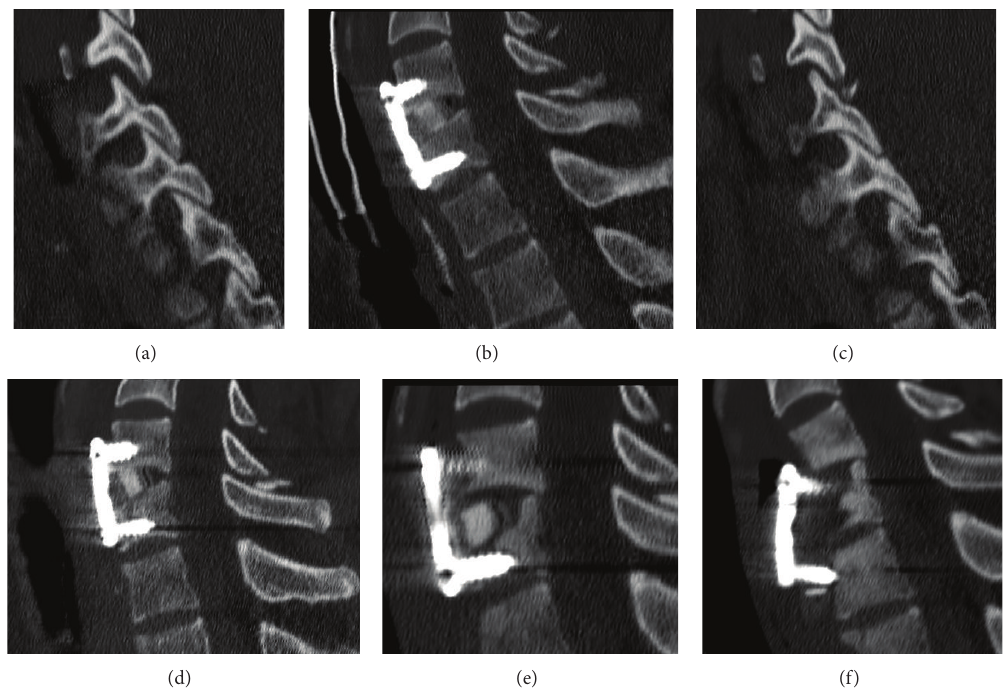
Figure 2: ((a), (b), and (c)) Postoperative CT scan demonstrating a good reduction of the listhesis and of the luxation of the facet joints. (d) One month from CT scan demonstrating stability of the implant. (e) Three-month CT scan showing initial bone reabsorption around the cervical cage. (f) Six-month CT scan demonstrating an almost complete anterior dislocation of the implants caused by massive bone destruction and